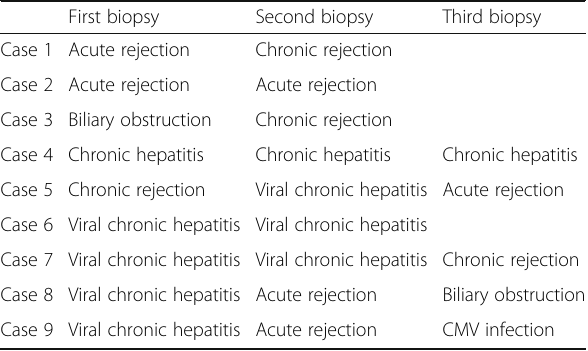
Table 4 Sequential finding of the first, second, and third liver